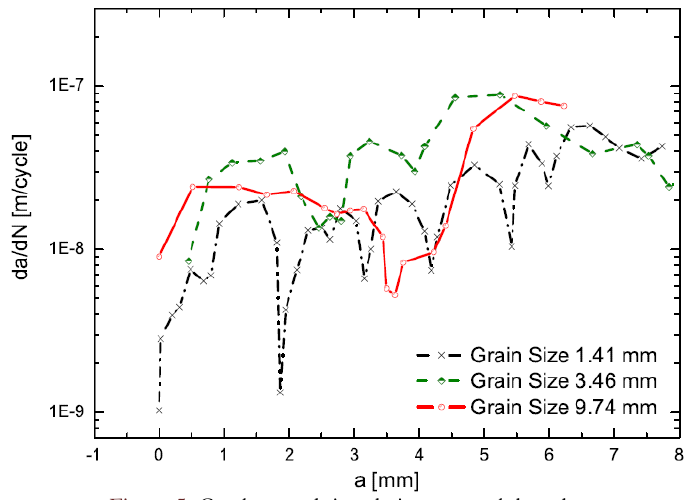
Figure 5: Crack growth in relation to crack